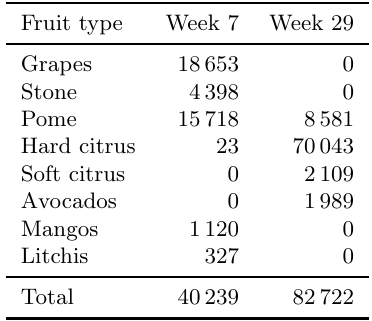
Table 4: Fruit export volumes (measured in pallets) during week 7 of 2003 (summer peak) and week 29 of 2003 (winter